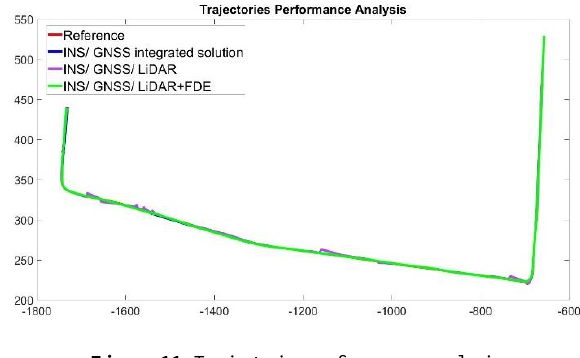
Figure 11. Trajectories performance analysis.